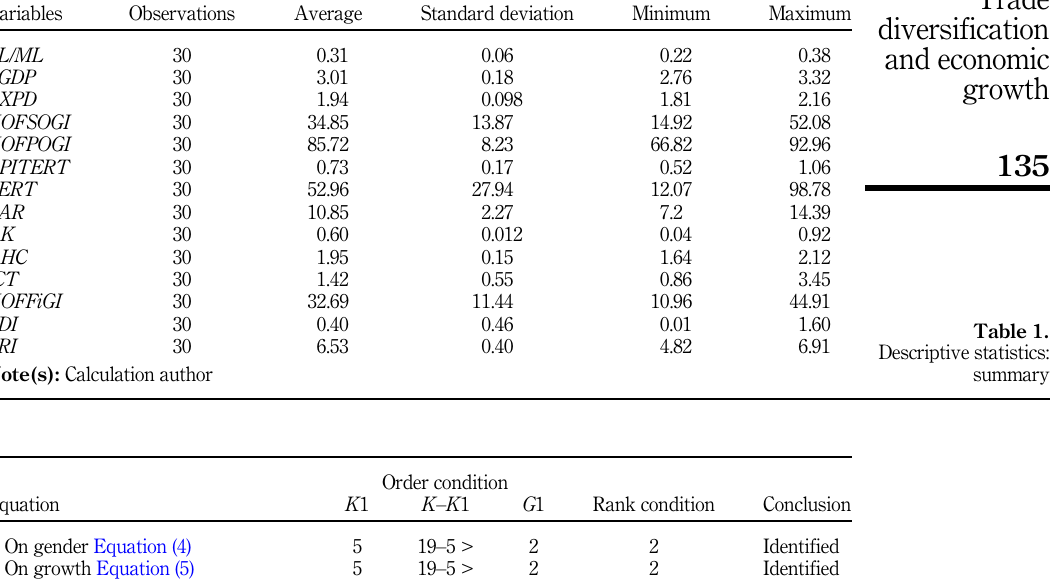
Table 2. Examination on